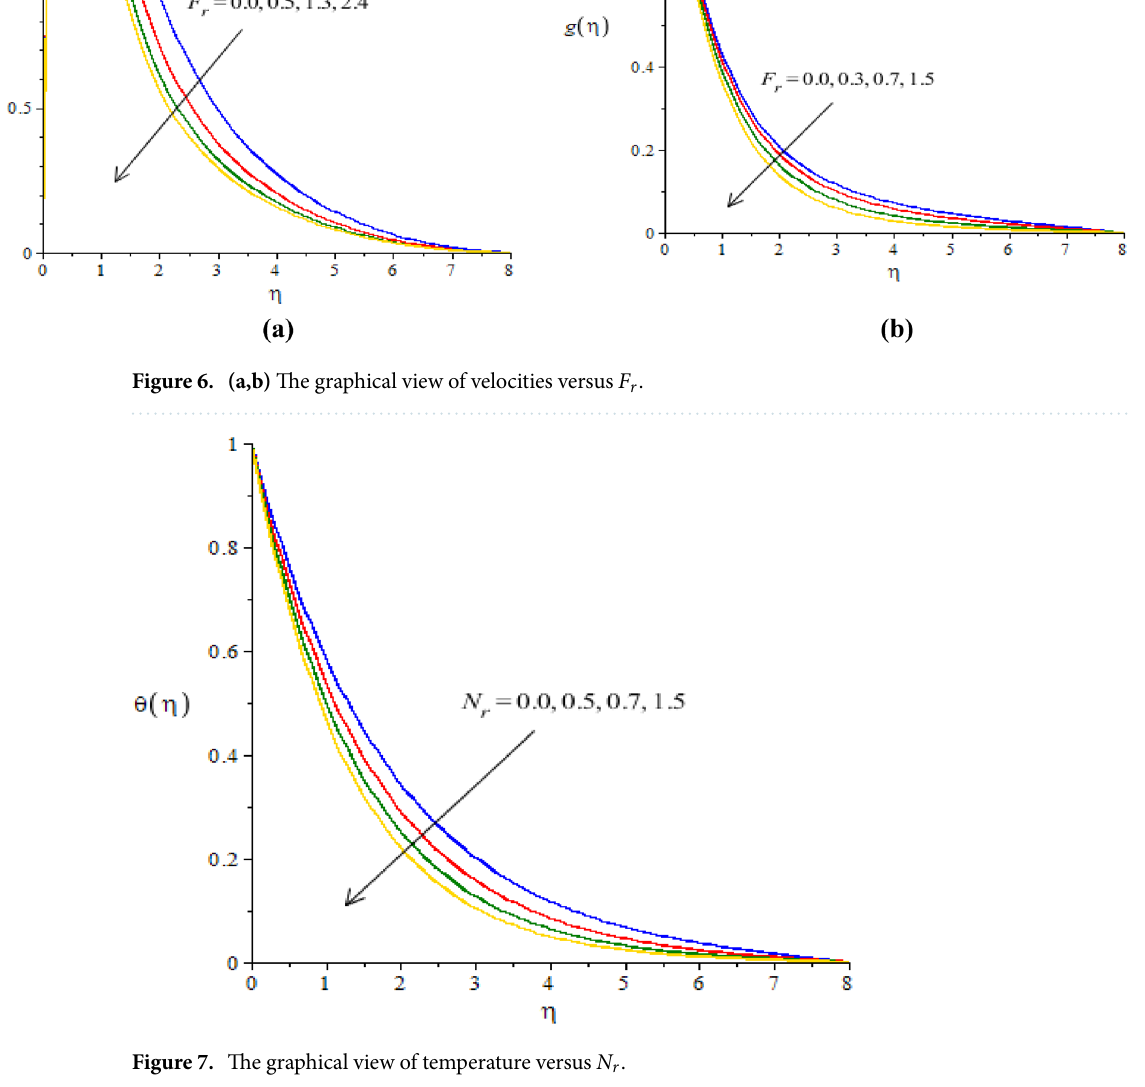
Figure 7. The graphical view of temperature versus N r